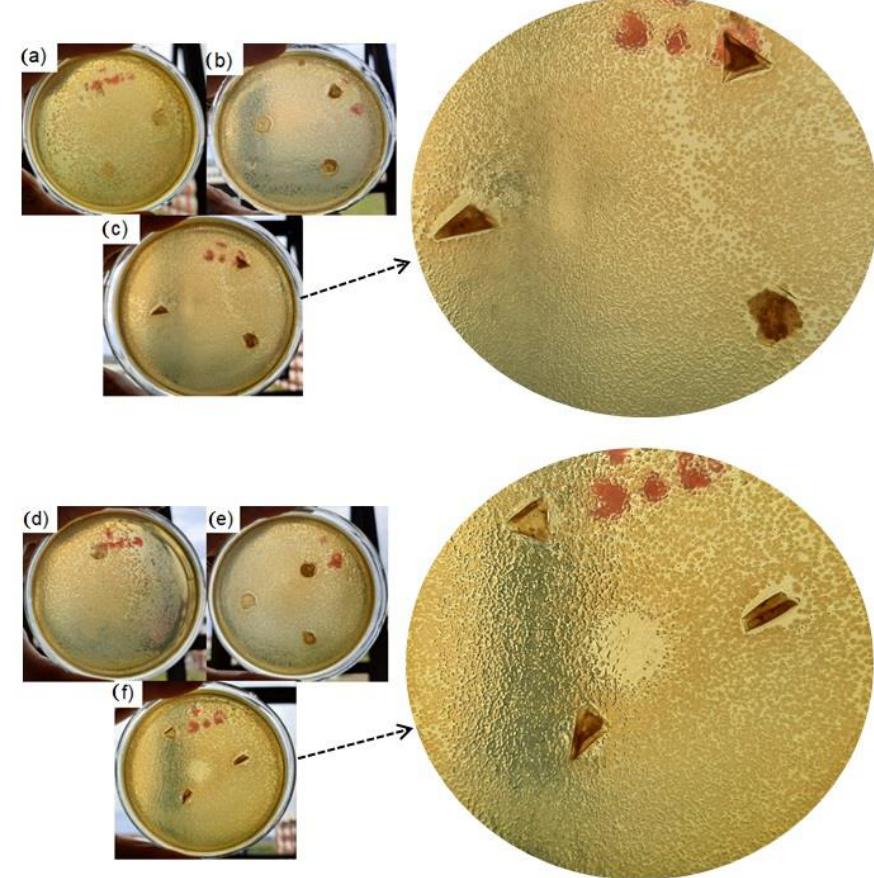
Figure 7. Microbial inhibition potential against E. coli for zein fiber ( a ), chitosan/zein fiber, ( b ) and chitosan/zein fiber + 3% of JPE ( c ) and against S. aureus for zein fiber ( d ), chitosan/zein fiber, ( e ) and chitosan/zein fiber + 3% of JPE ( f ). Table 5. The inhibition of halos (mm) against E. coli and S. aureus of the zein fiber and the bilayer films.